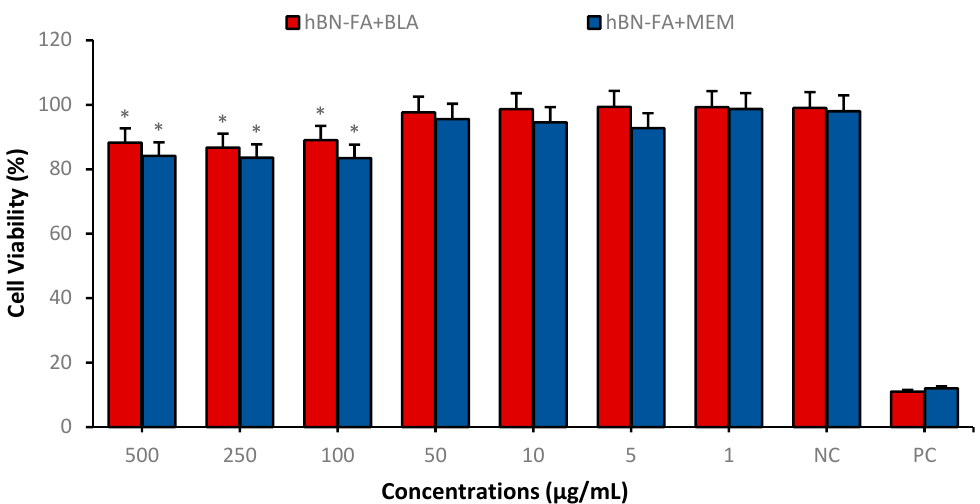
Figure 11. Cytotoxicity of hBN-FA+BLA and hBN-FA+MEM (0–500 µg/mL) on differentiated SHSY-5Y cell lines for 24 h using MTT assay. Symbol (*) represents a statistically significant difference compared to the negative control.